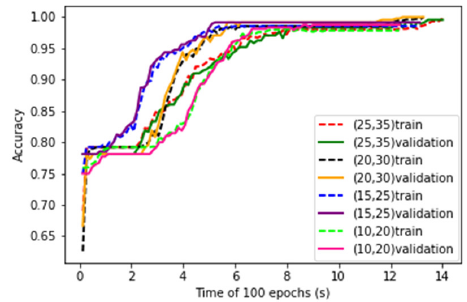
Figure 8. Training and validation curves of LeNet-5 with different number of convolution kernels.